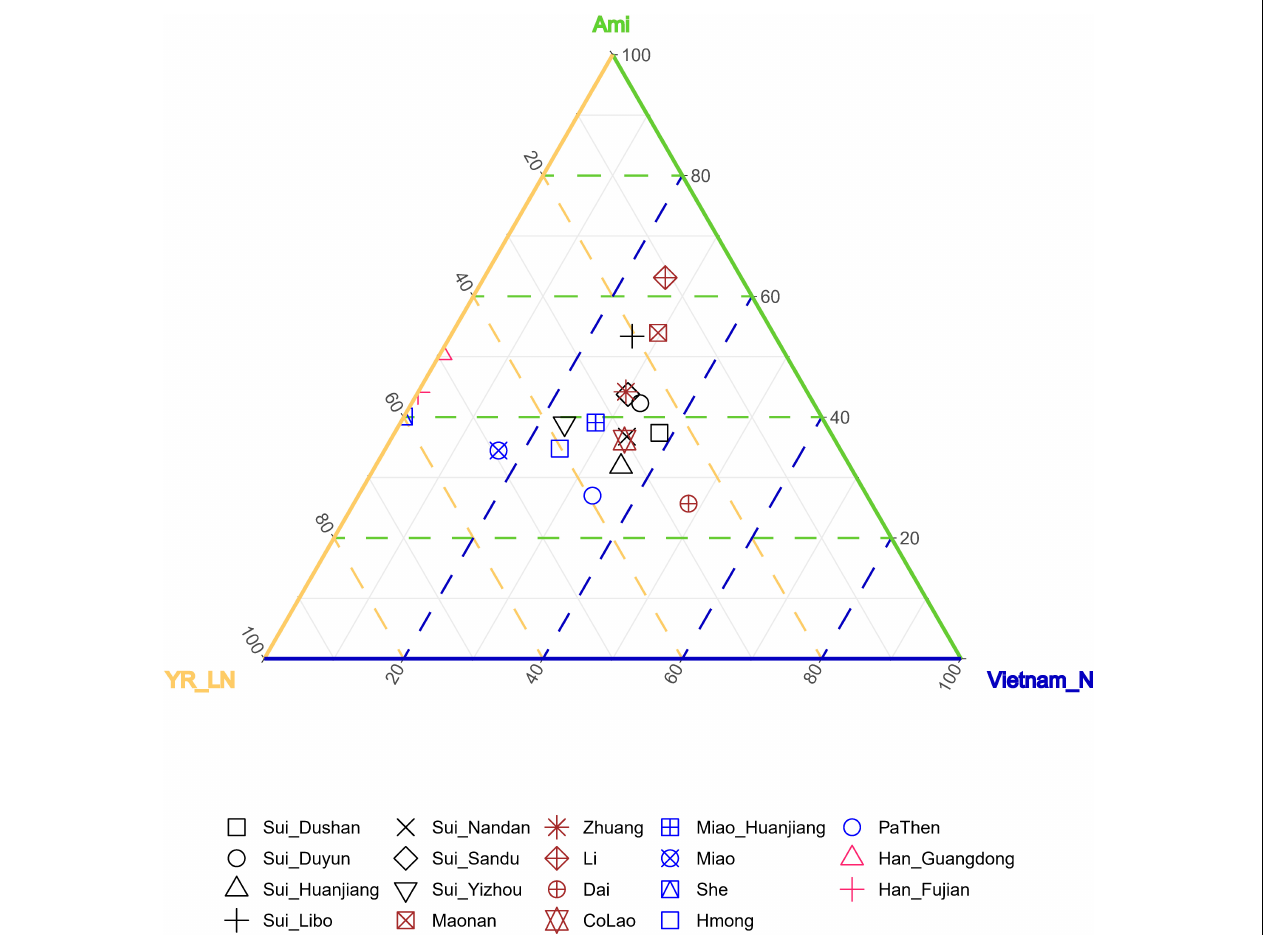
FIGURE 9 | Ancestry mixture coefficients in the three-way admixture model via qpAdm . We used Inland Southeast Asian (represented by Vietnam_N), Coastal Southeast Asian (represented by Ami) and North East Asian (represented by YR_LN) as three proxies of the possible ancestral sources of studied Sui. Mbuti, Tianyuan, Papuan, Onge, Liangdao2, DevilsCave_N, Japan_Jomon, Mongolia_N_East, Malaysia_LN were used as outgroups. The Nested p -value > 0.05 when Han_Fujian, Han_Guangdong and She were used as target, suggesting it may be appropriate to drop Vietnam_N source from the model, so we finally showed the admixture proportions in two-way admixture model for these three groups in this